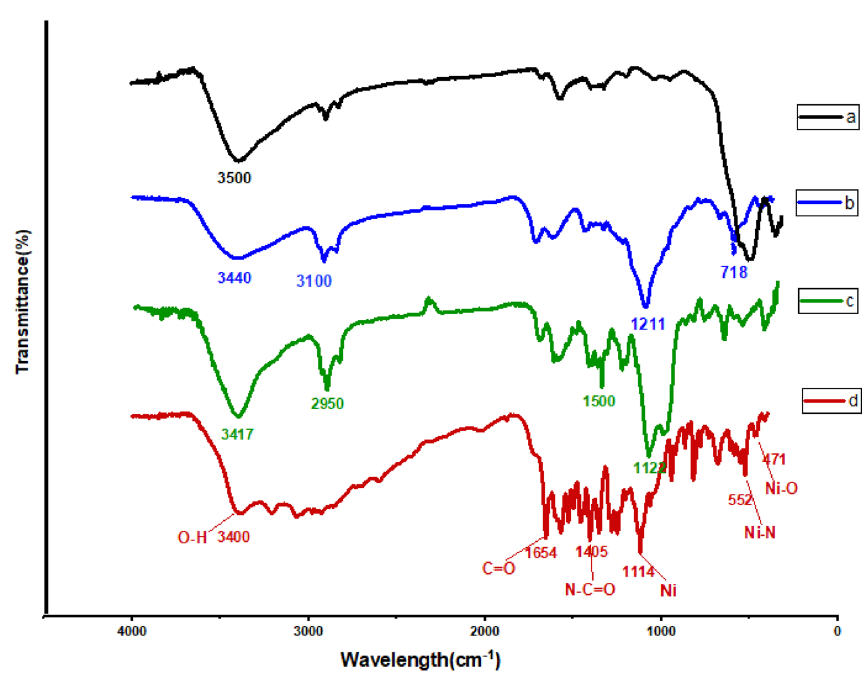
Figure 4. FT-IR spectra of Fe 3 O 4 ( a ), Fe 3 O 4 @CPTMO ( b ), Fe 3 O 4 @CPTMO-phenylalanine ( c ), and Fe 3 O 4 @ CPTMO-phenylalanine-Ni ( d